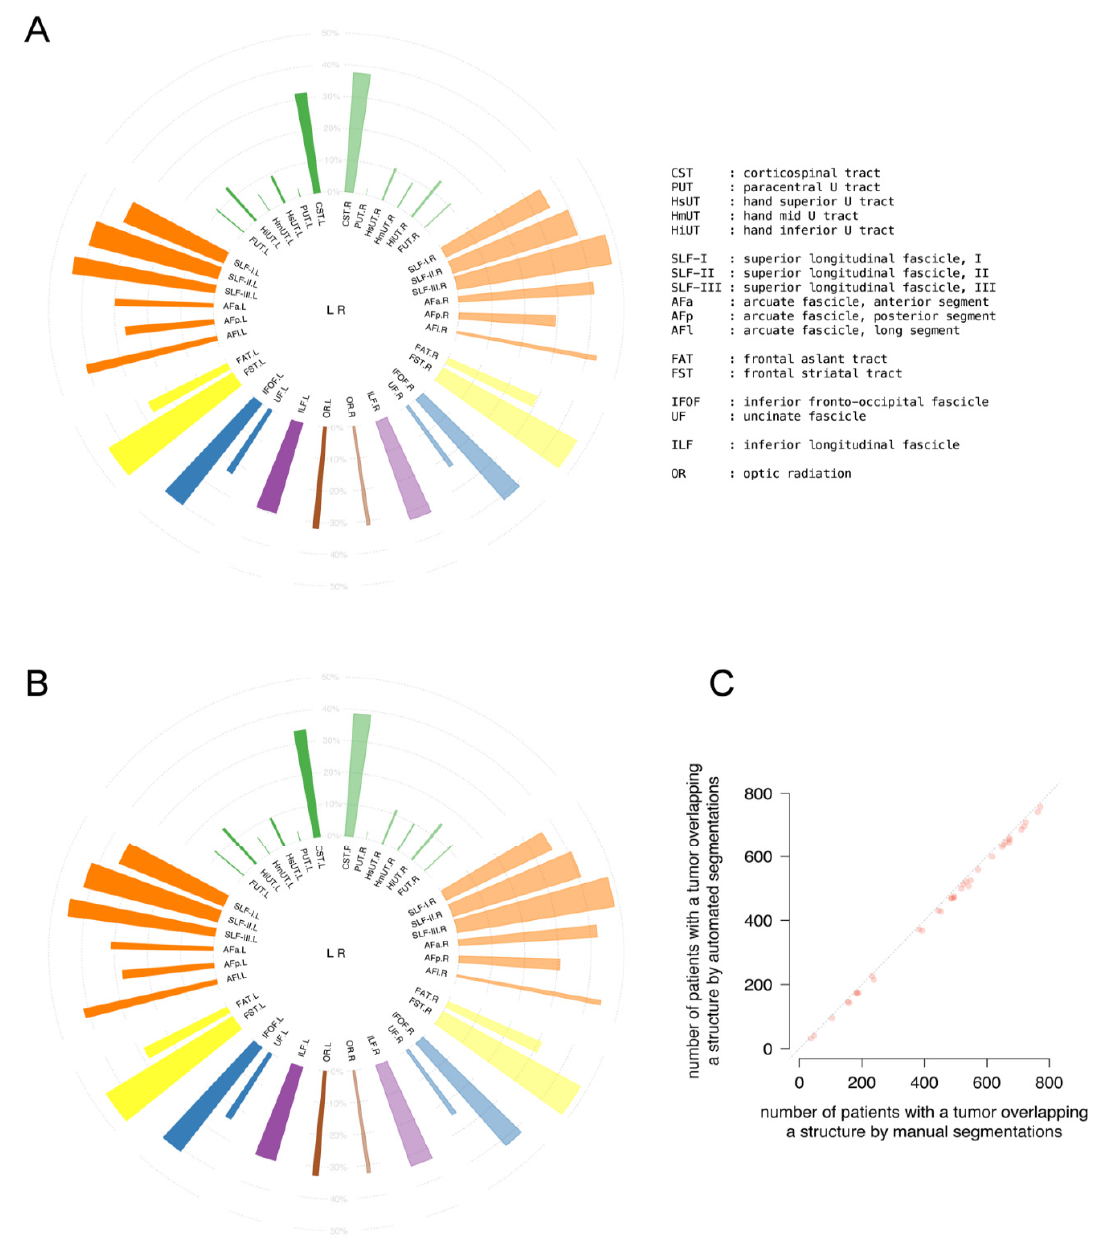
Figure 5. Comparison of tumor location profiles of subcortical white matter structures between ( A ) automated and ( B ) manual segmentations. In the circular bar plots, each bar represents one tract or tract segment. Abbreviations refer to structures as detailed in legend. The height of a bar represents the percentage of patients with tumor involvement in a structure indicated in grey. The width of a bar corresponds with the relative volume of a structure. ( C ) Correlation plot between the number of patients with structure involvement between the manual and automated segmentations. The dotted diagonal indicates the identity